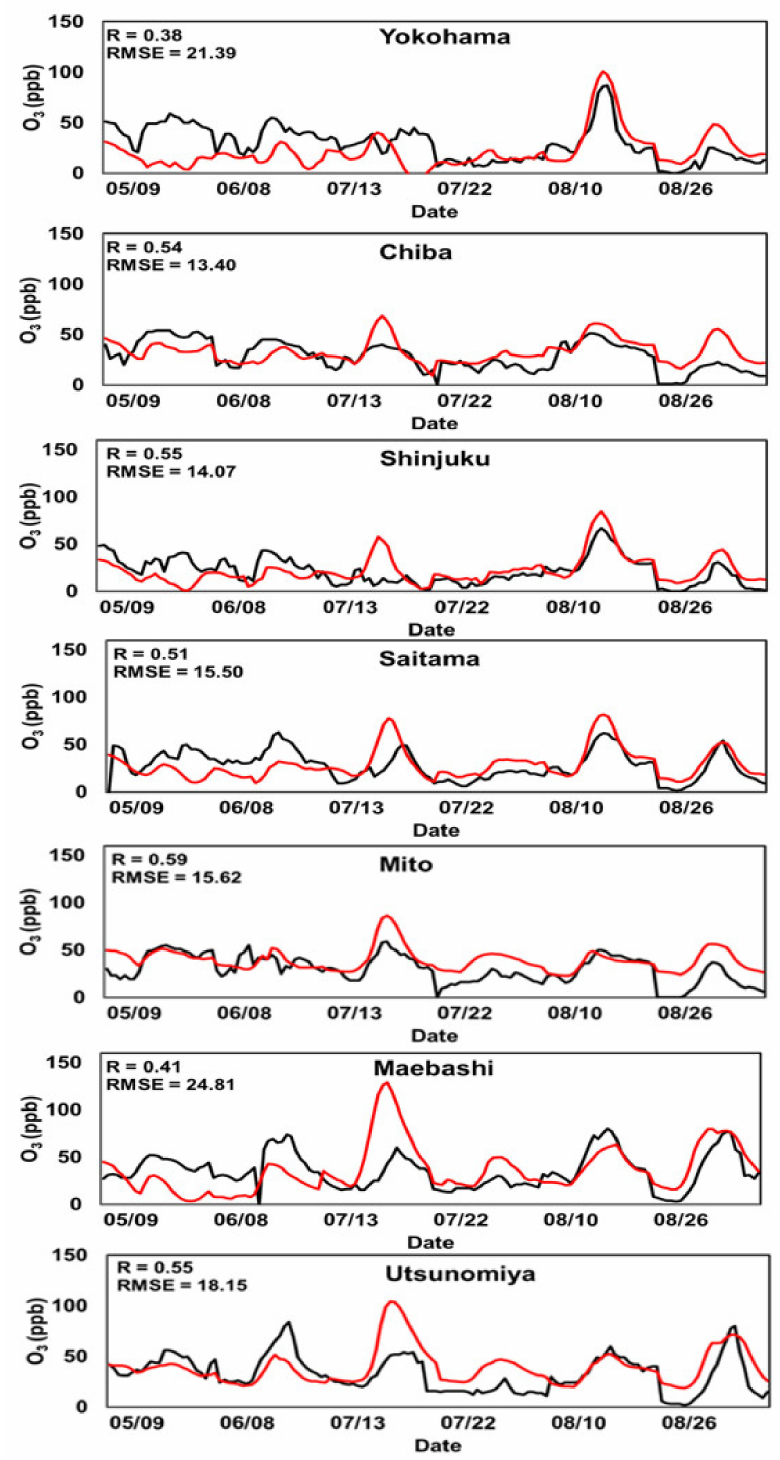
Figure 2. Hourly data comparison between the observed ( black line ) and modeled ( red line ) ozone (O 3 ) concentrations during the 2016 ozone season in seven regions of